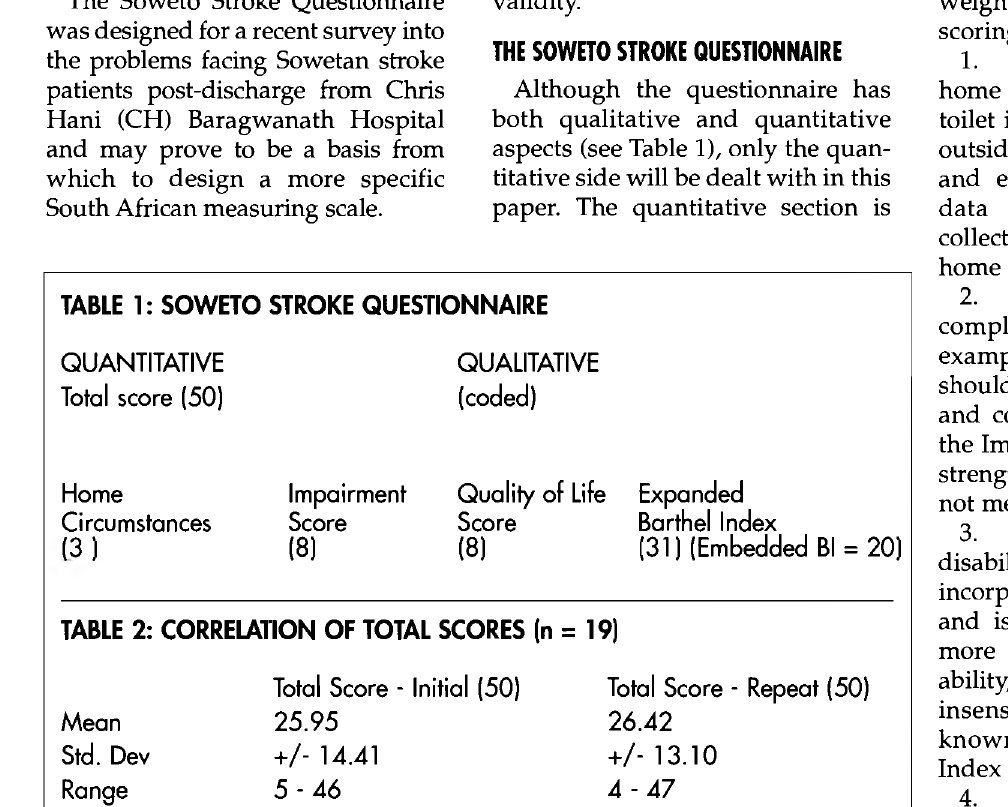
TABLE 3: CORRELATION OF IMPAIRMENT SCORES (n = 19)